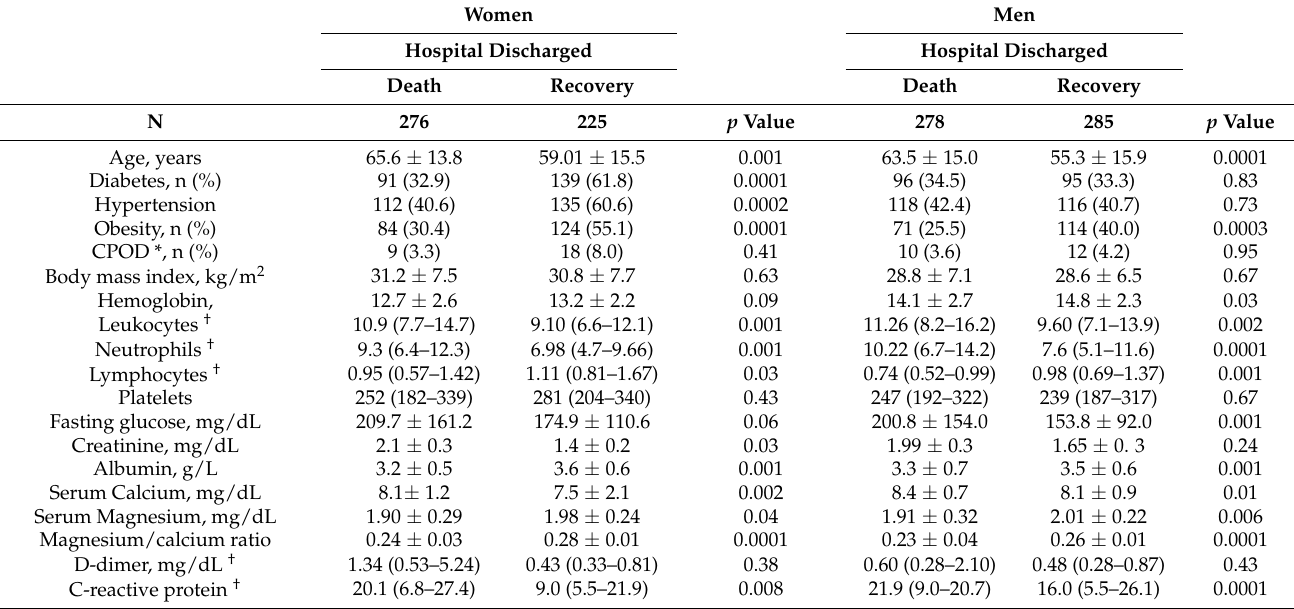
Table 2. Characteristics of the target population, N =